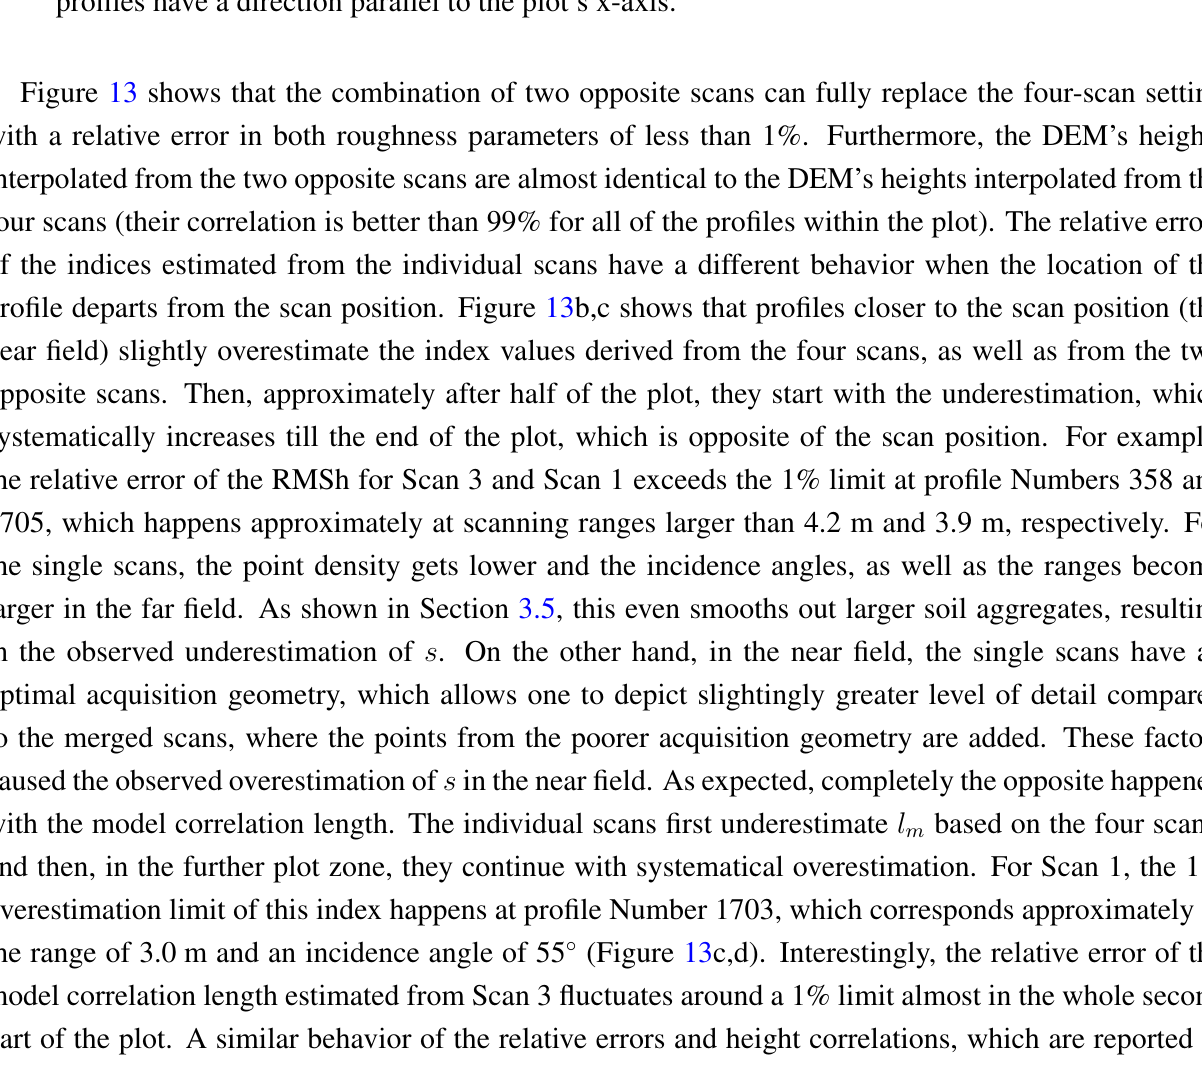
Figure 13. Comparison of ( a ) profile heights, ( b ) RMS height and ( c ) model correlation length, estimates based on single scans (green and blue lines) or two opposite scans (black lines) with respect to the corresponding estimates based on the four scans. The analyzed profiles have a direction parallel to the plot’s